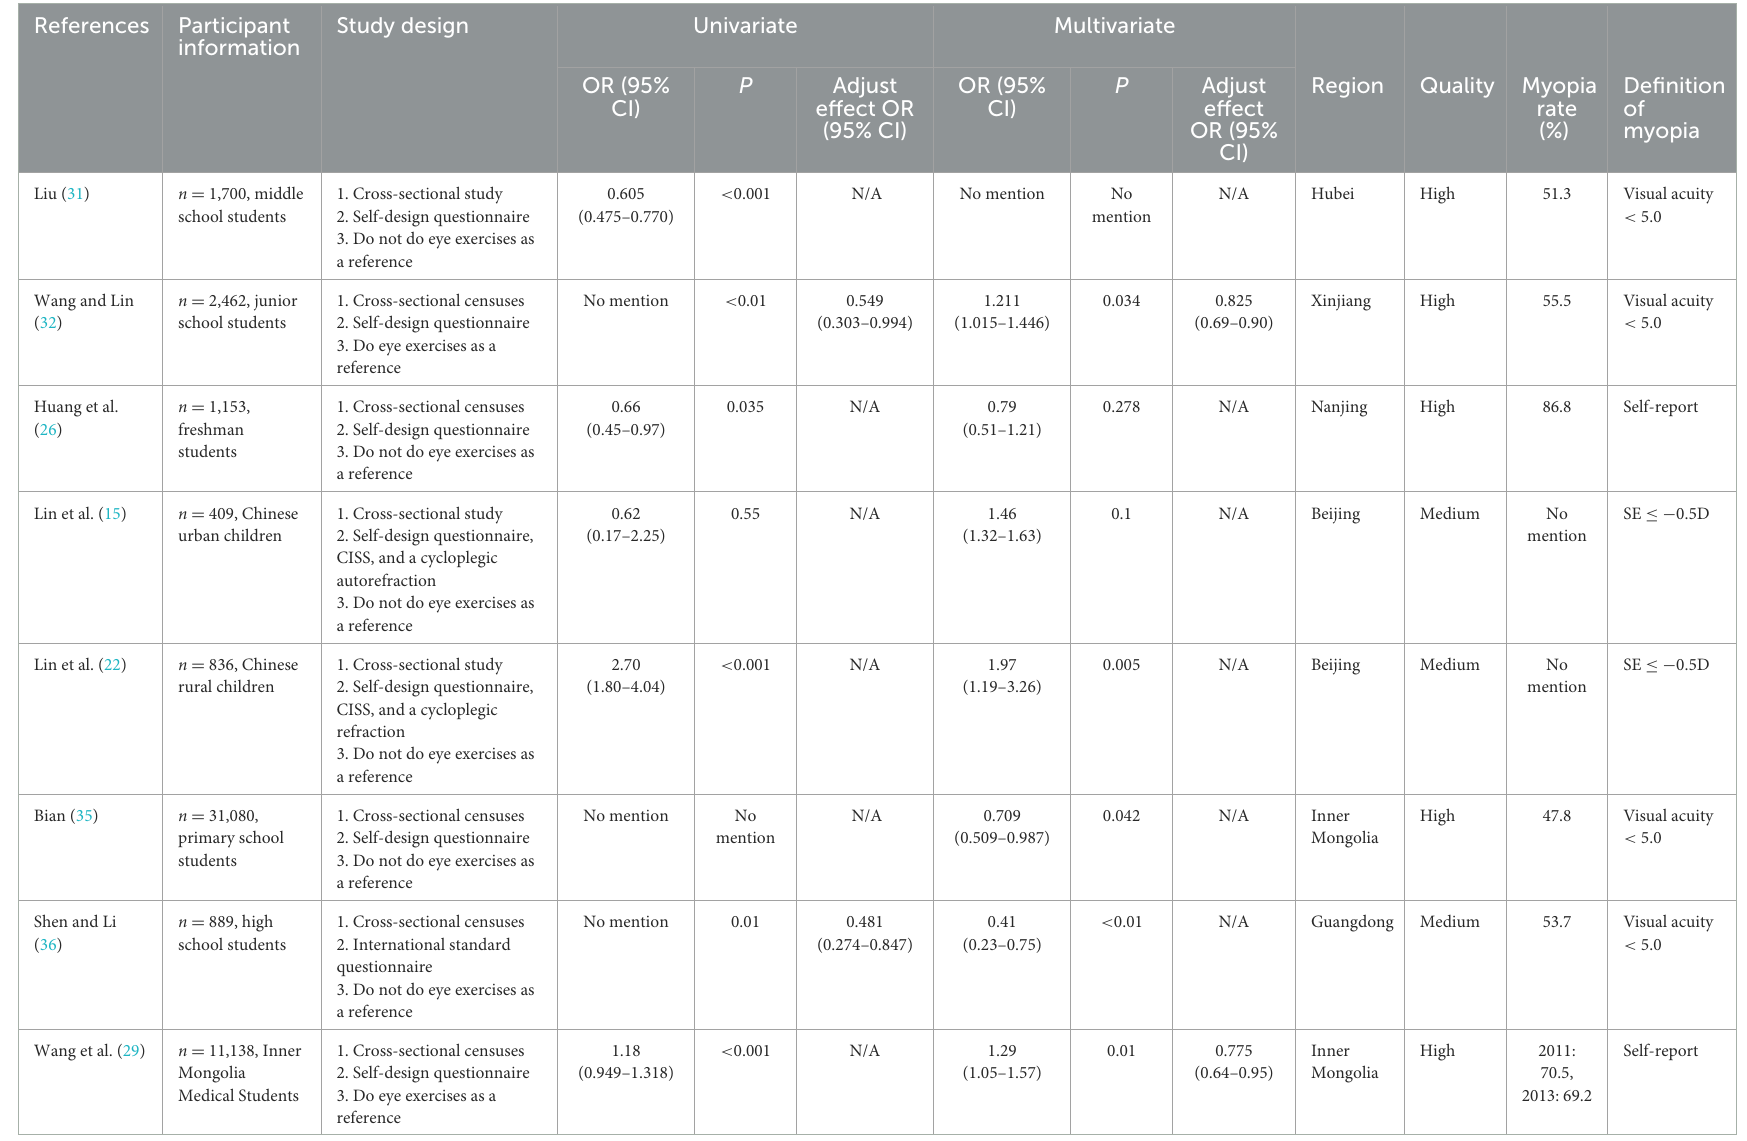
TABLE 1 Characteristics of the 12 studies included in the meta-analysis of eye exercises and